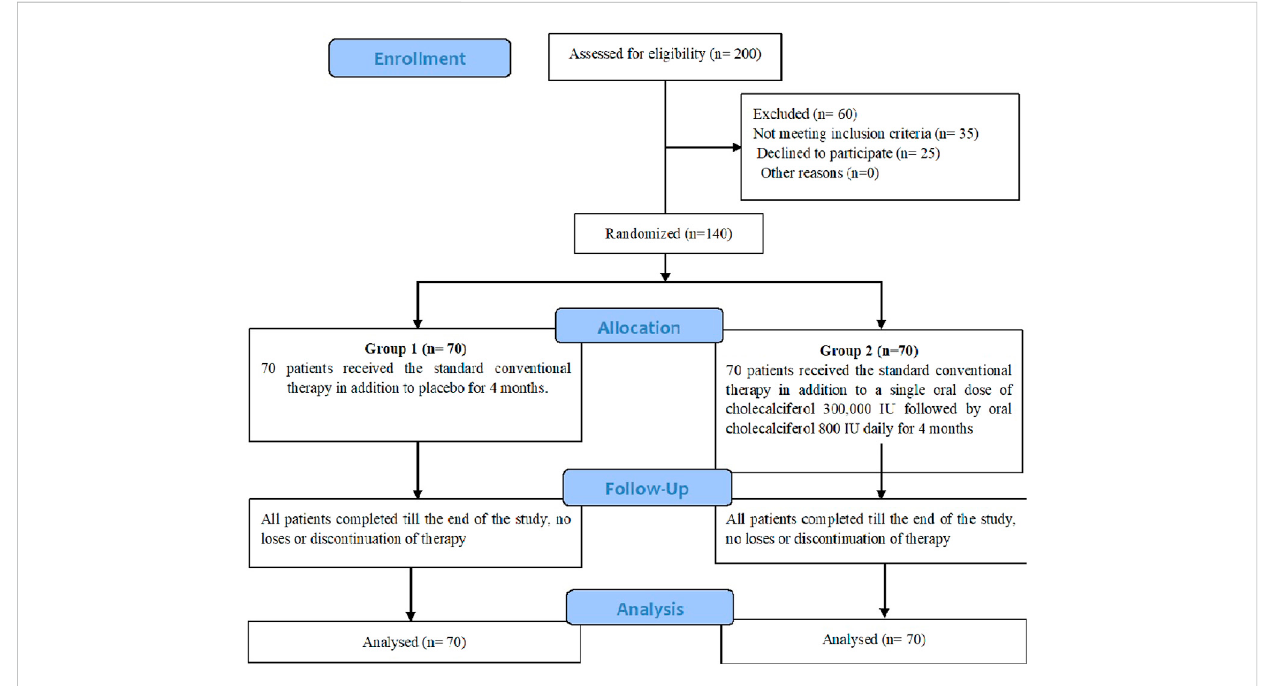
FIGURE 1 CONSORT fl ow diagram of patient